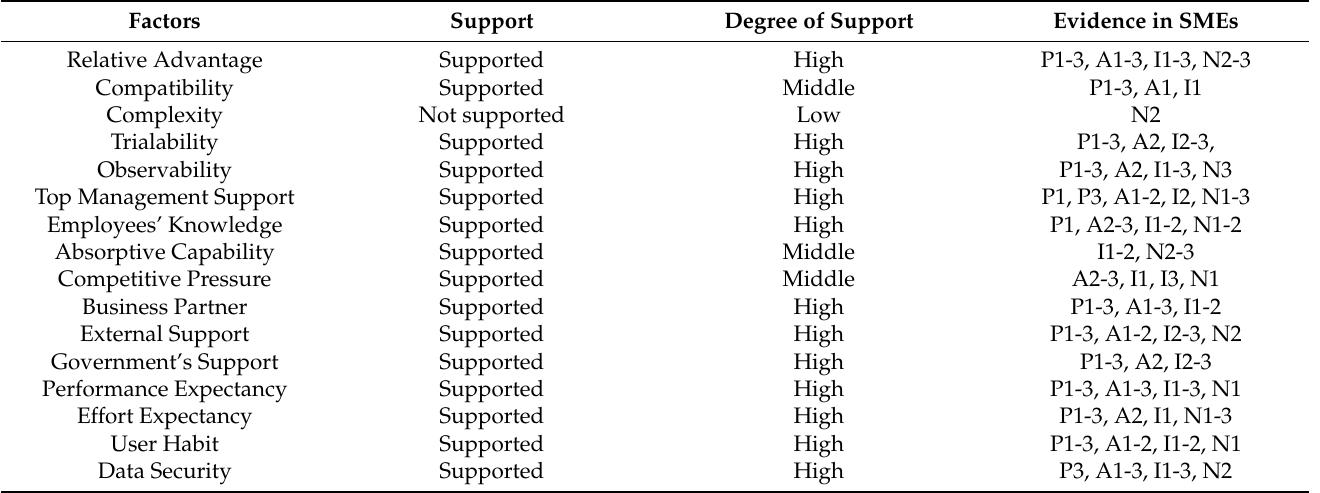
Table 1. Summary of qualitative interviews’